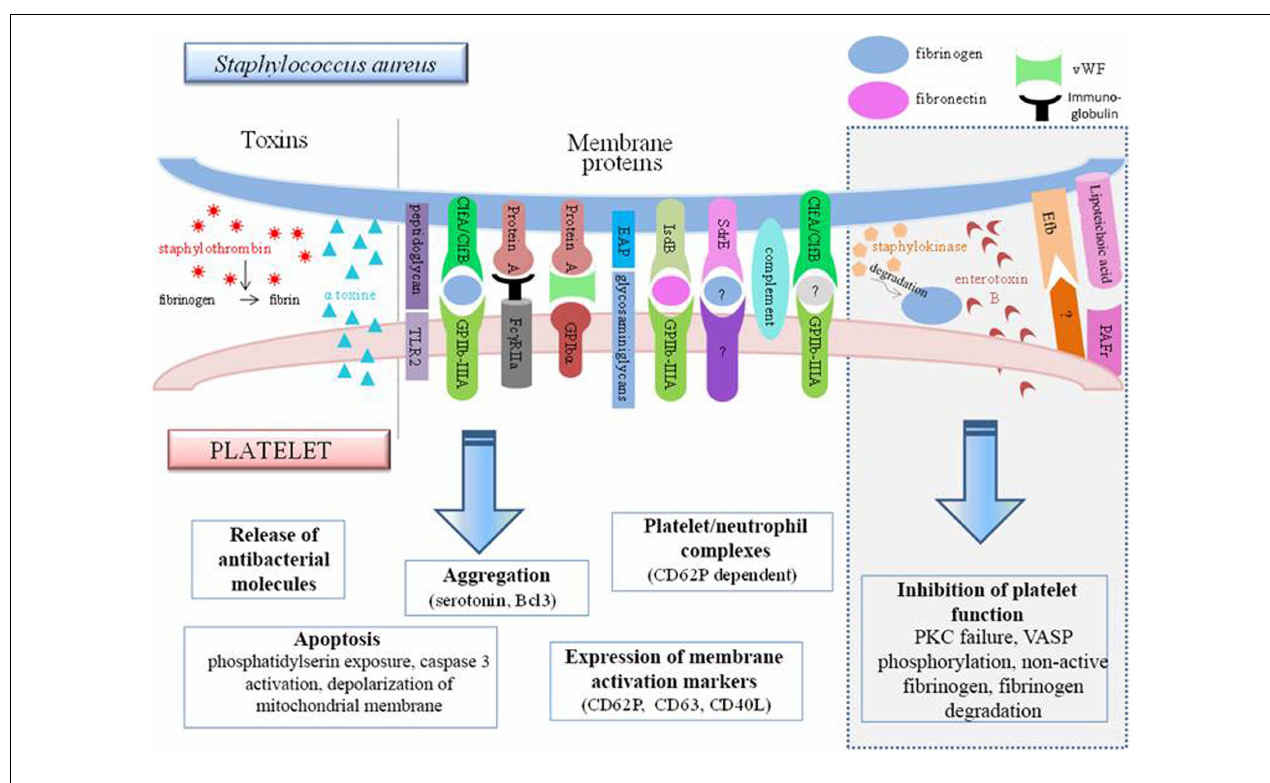
diagram).TLR,Toll-like receptor; Clf, clumping factor; Fc γ R, Fc γ receptor; EAP, extracellular adherence protein; Isd, iron-regulated surface determinant; Sdr, serine–aspartate repeat protein; Efb, extracellular fibrinogen-binding protein; PAFR, platelet-activating factor